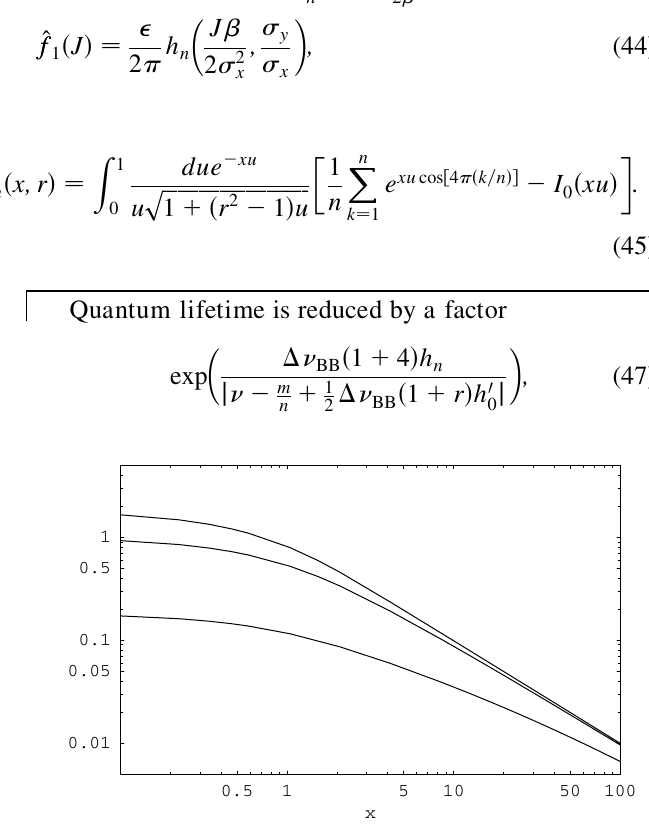
(cid:2) x; r (cid:4) =@x versus x 0